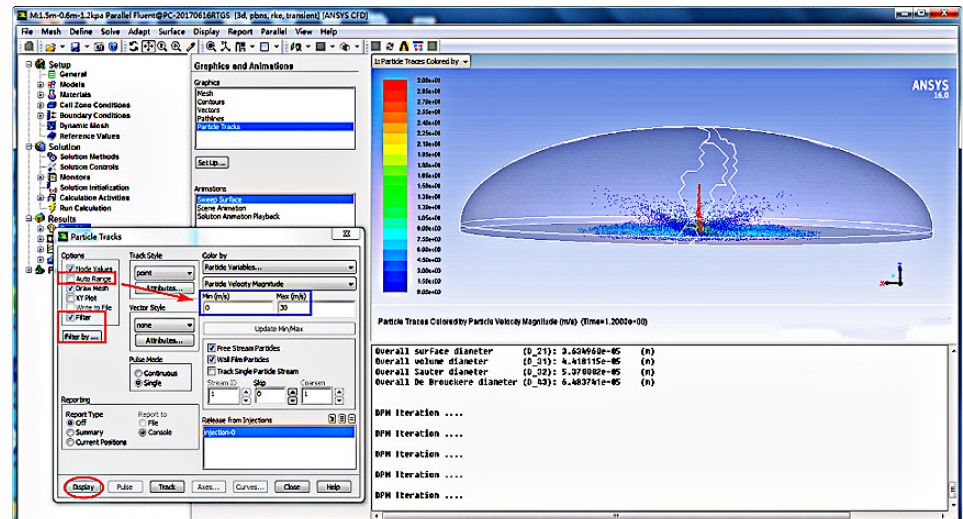
Figure 29. Liquid film thickness clouds for an ultra-large ellipsoidal recovery hood.